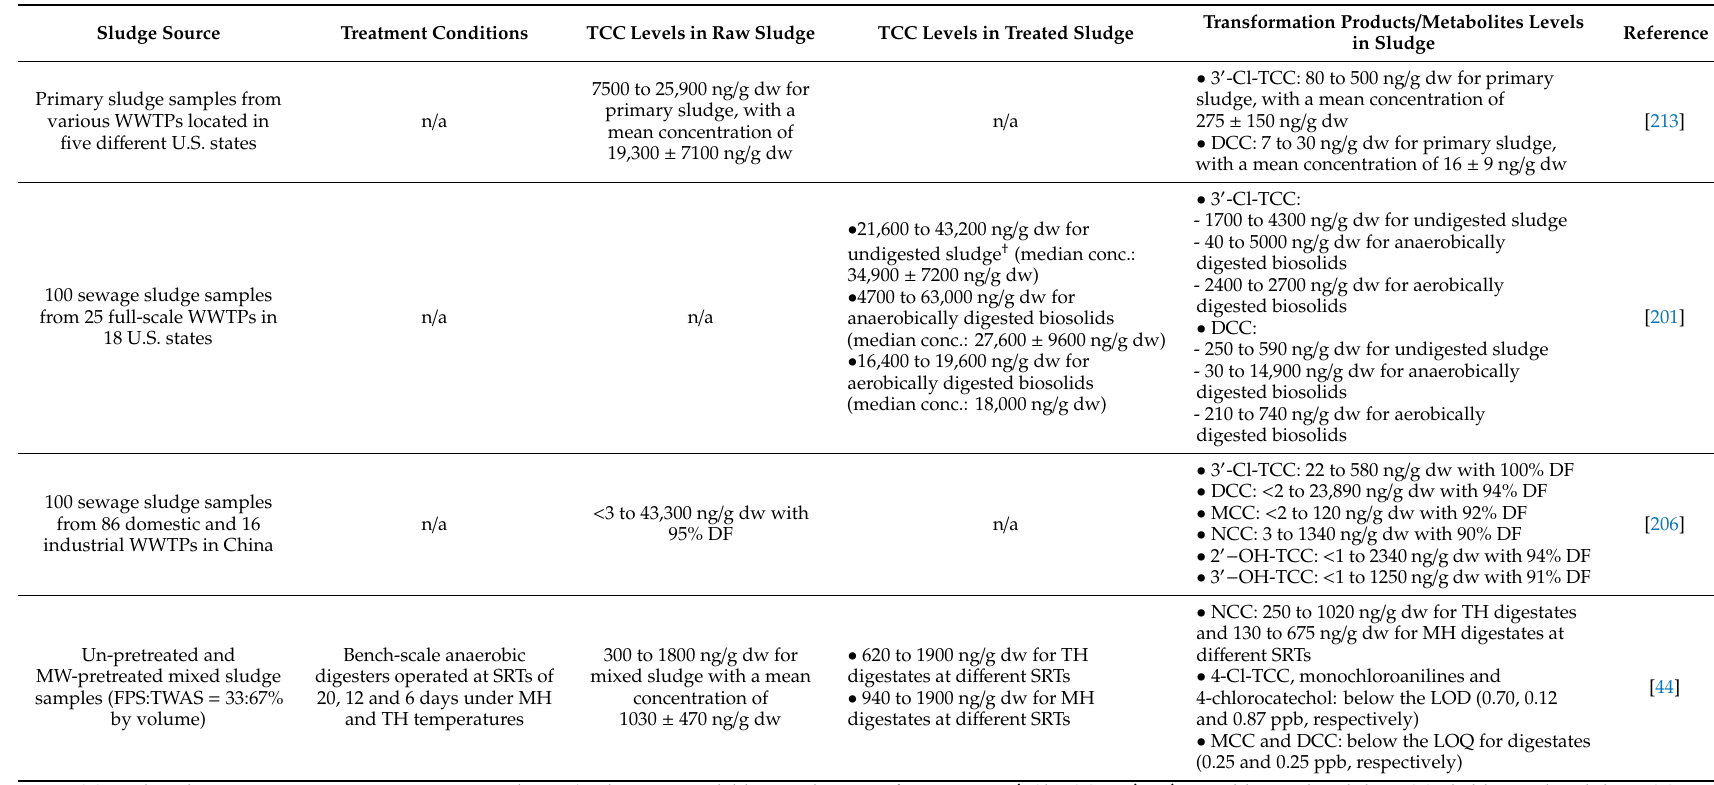
Table 4. Occurrences of triclocarban and its transformation products / metabolites in sludge and